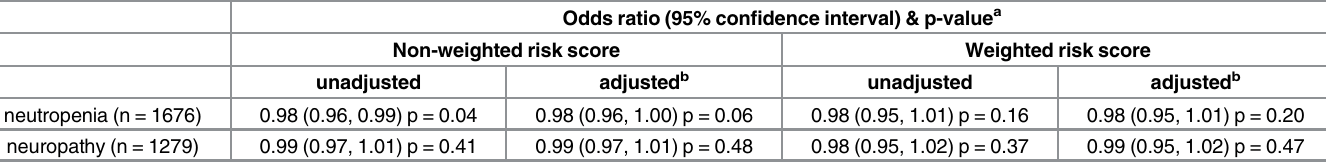
Table 3. Association of polygenic risk scores with chemotherapy-related neutropenia and taxane-related sensory neuropathy. Odds ratio (95% con fi dence interval) & p-value